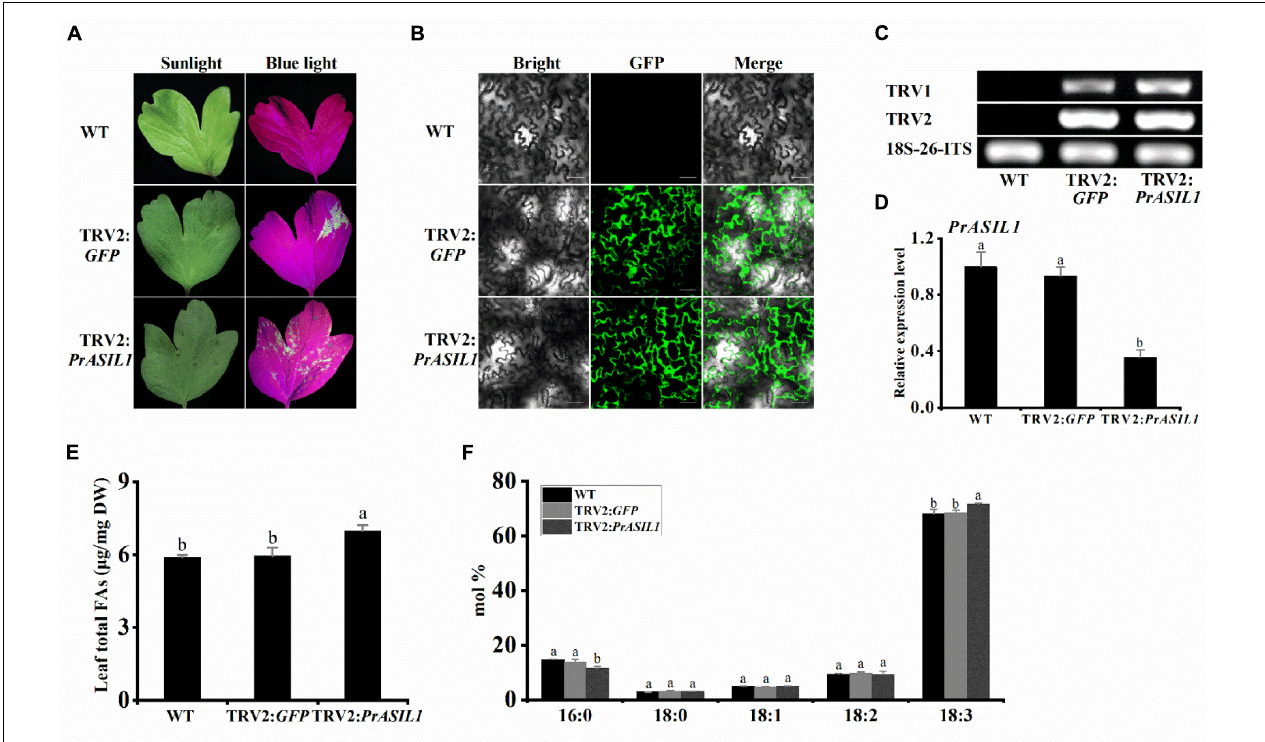
FIGURE 7 | Reduced expression of PrASIL1 in Paeonia rockii enhances the oil content and affects FA composition. (A) Image of P. rockii leaves infected with TRV2- GFP or TRV2- PrASIL1 at 6 days post-infiltration under blue light. (B) Confocal microscopy image of P. rockii leaf tissue infected with TRV2- GFP or TRV2- PrASIL1 at 6 days post-infiltration. Bars = 30 µ m. (C) RT-PCR analysis of TRV1 and TRV2 accumulation levels in P. rockii leaf tissue at 2 weeks post-infiltration. (D) Silencing efficiency of PrASIL1 determined by qRT-PCR analysis. Relative expression of PrASIL1 was normalized to 18S-26S ITS and calibrated to the levels of WT leaves. (E) Comparisons of total FA content ( µ g/mg) among the WT, TRV2: GFP control, and PrASIL1 -silenced plants. (F) Fatty acid composition of WT, TRV2: GFP control, and PrASIL1 -silenced plants. DW, Dry weight. Values are mean ± SD ( n = 3). Different letters indicate significant difference at P < 0.05, as confirmed by one-way ANOVA with Tukey’s